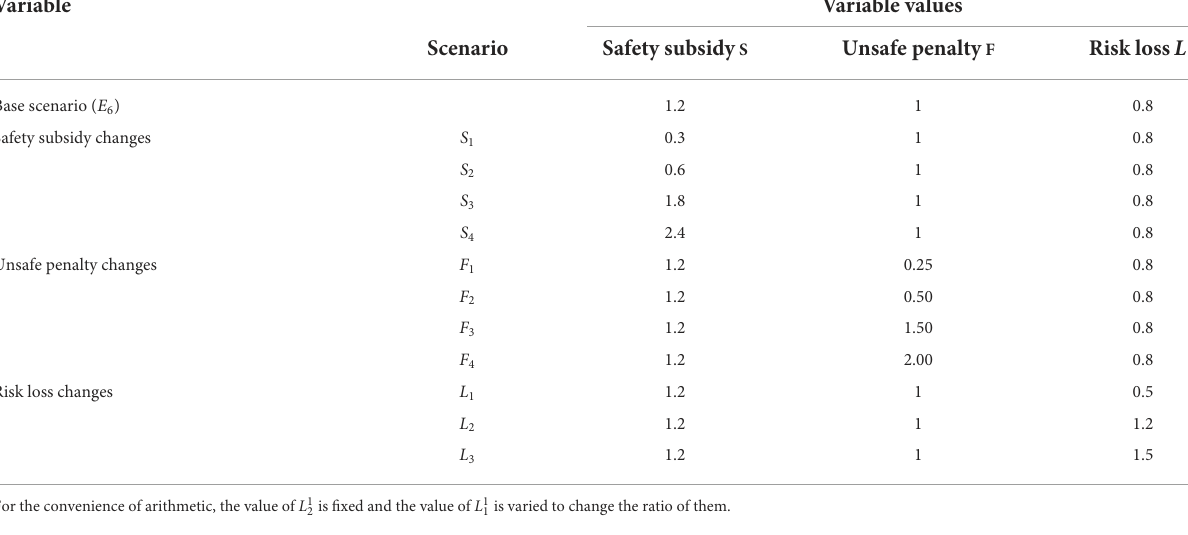
TABLE 6 Simulation scenario setting.